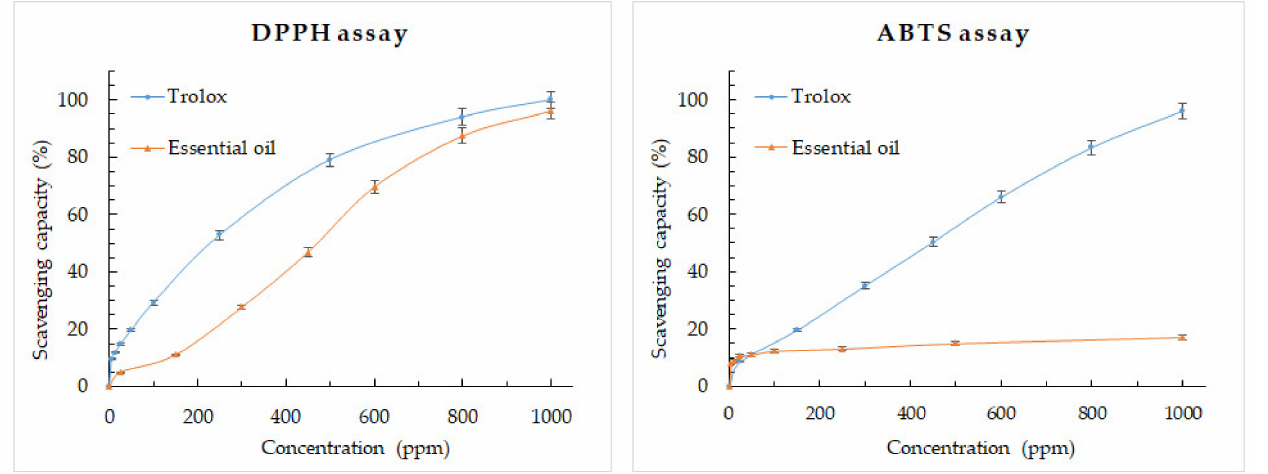
Figure 1. Scavenging capacity vs. concentration of Annona cherimola essential oil obtained by DPPH and ABTS assays.